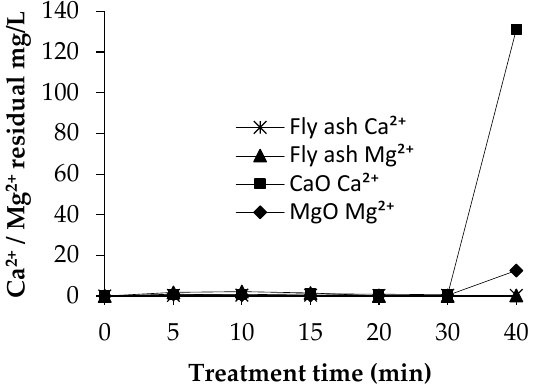
Figure 5. Atomic absorption spectroscopy (AAS) characterization of residual concentrations of Ca 2+ and Mg 2+ during the fly ash, CaO, and MgO experiments, at 20 °C.